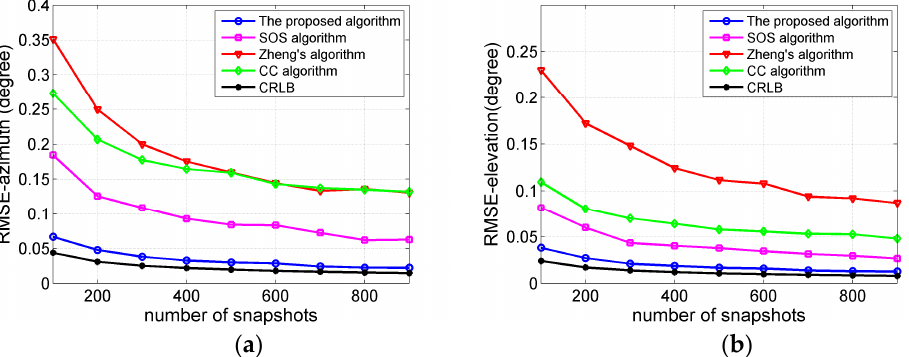
Figure 4. ( a ) RMSE curves of the central azimuth DOA estimations versus the number of snapshots; ( b ) RMSE curves of the central elevation DOA estimations versus the number of snapshots.